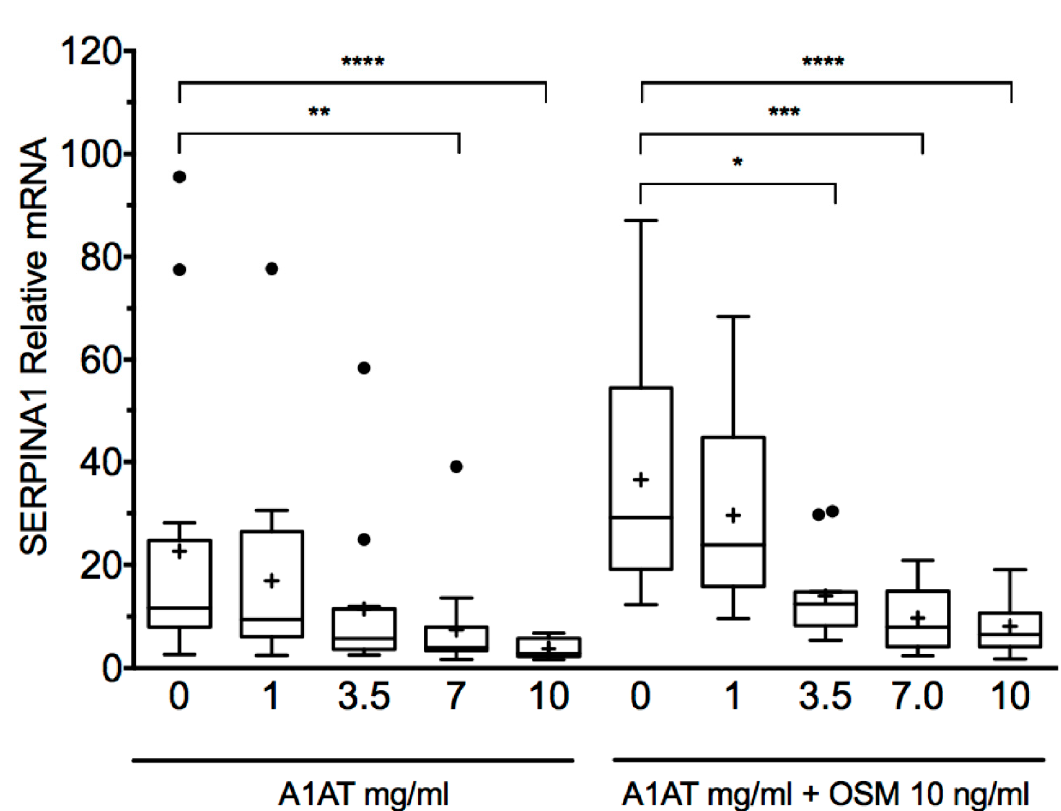
Figure 3. Purified A1AT reduces SERPINA1 expression in a dose-dependent manner in primary human hepatocytes. Exogenously added purified AAT reduced SERPINA1 expression in primary human hepatocytes isolated from both proficient and deficient liver tissue. The reduction was more prominent following Oncostatin M (OSM 10 ng / mL) stimulation, known to increase expression of SERPINA1. *, P < 0.05; **, P < 0.001; ***, P < 0.001; ****, P < 0.0001). © 2017 Karadagi, et al. This is an